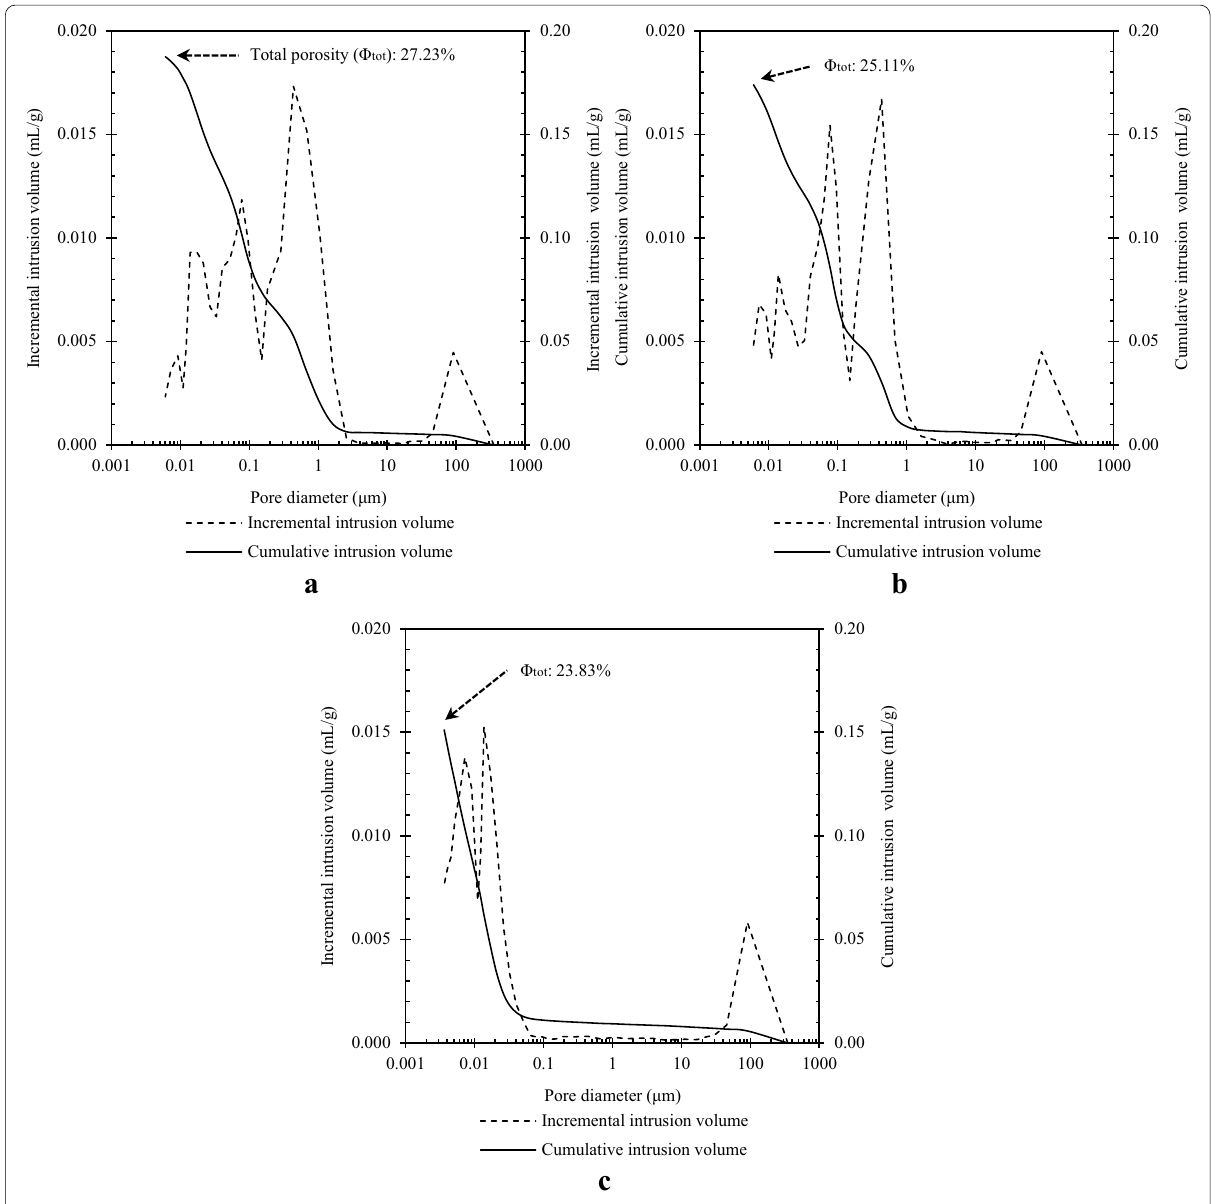
Fig. 4 Mercury-intruded volume at a given pore diameter for samples obtained from concrete with different mix proportions cured for 28 days: a O100, b OG50, c OG30F20.